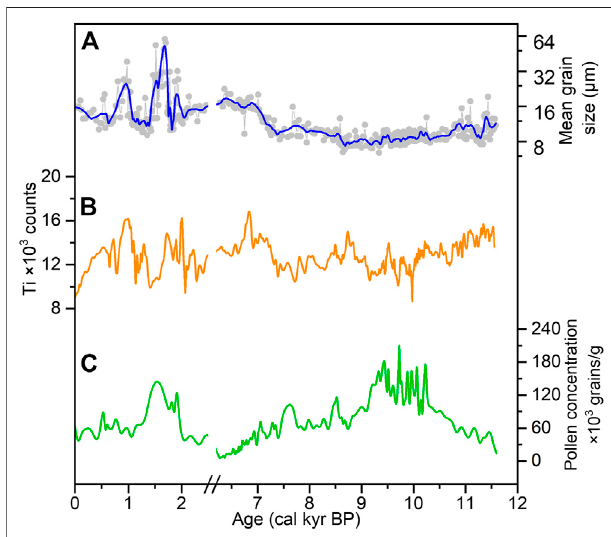
FIGURE6| Meangrainsize, (A) theTicontent, (B) pollenconcentration, and (C) (Li et al., 2020) of Chagan Nur.